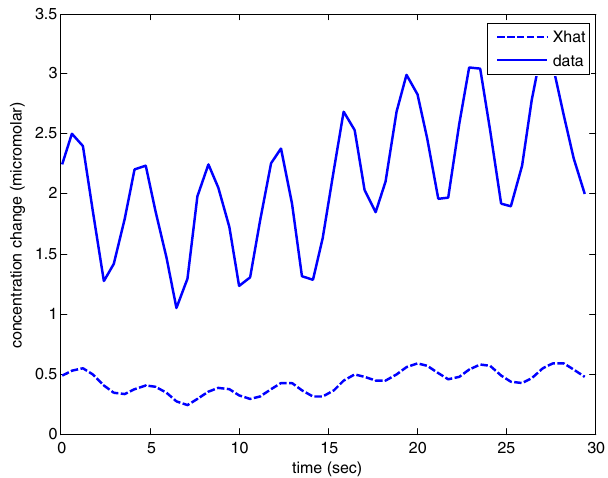
Fig. 5. An actual experimental contaminated signal (solid line) from stage 2 where the subject was moving his/her head and denoised signal (dashed line) after using AR based